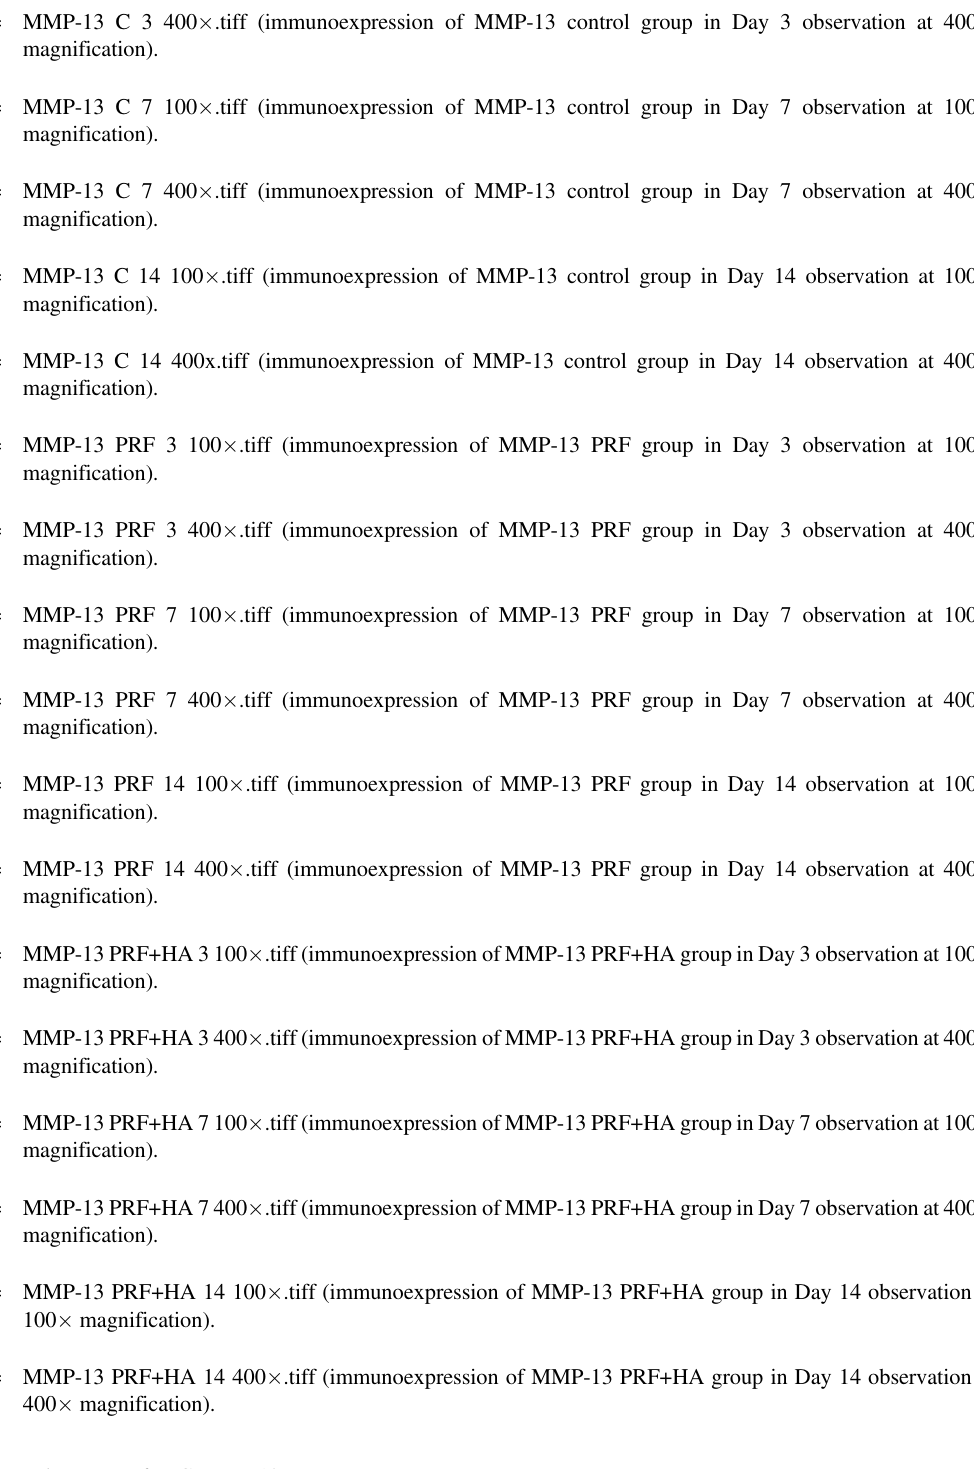
Figshare: Histoscore of IHC MMP-13 https://doi.org/10.6084/m9.figshare.16531398.